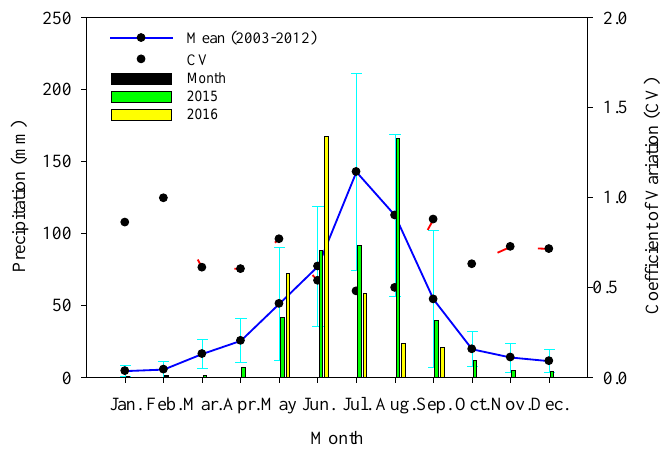
Figure 2 . Monthly mean precipitation in 2015 and 2016, and monthly mean precipitation and associated variation from January to December in 2003–2013 in Harbin city, Heilongjiang province, China.